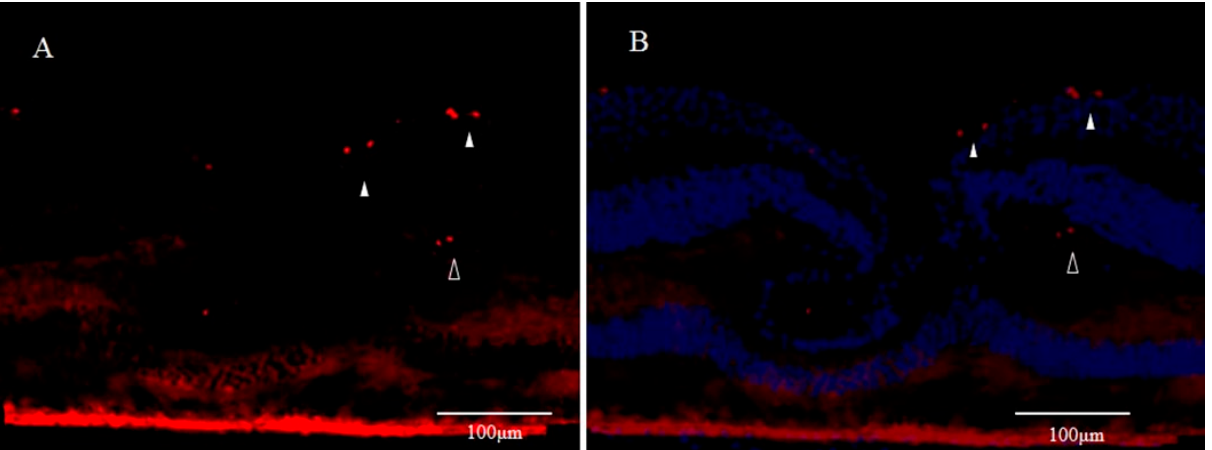
Figure 3. Immunostaining for Ki67 of Monkey Foveal Retina (cited from Reference [77]); ( A ) Scattered Ki67-positive spots (red) are visible in the innermost retinal layer in the parafoveola (white arrowheads). Moreover, some parts of the region believed to be the inner granular layer are also positive (unfilled arrowheads); ( B ) Immunostaining for Ki67 includes the immunostaining for DAPI (blue).